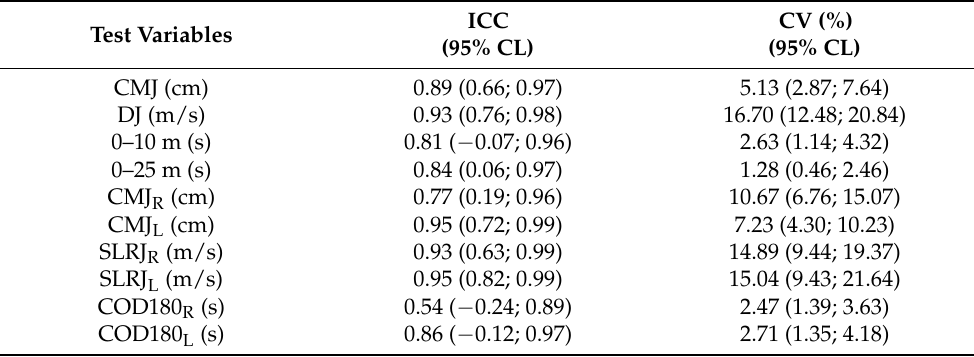
Table 2. Reliability data for test variables. Data are presented as value with lower and upper confidence